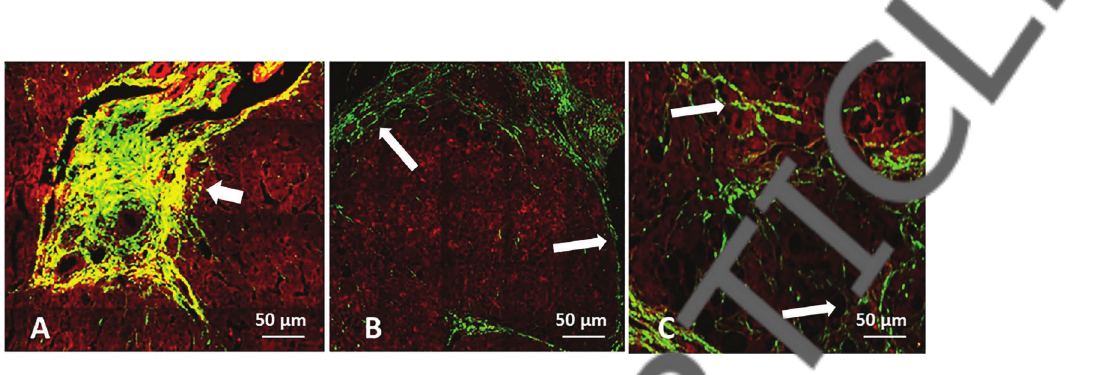
Figure 4. Second harmonic generation and two-photon excited fl uorescence images of different patterns of fi brosis by different etiologies. Collagen is stained green and liver cell structure is stained red. A , Primary biliary fi brosis, in which fi brosis began in portal tracts (arrow). B , Chronic hepatitis B, in which expanded portal tracts are linked by fi brous tissue and slender bridge septa are connected to a portal tract and central vein (arrows). C , Non-alcoholic steatohepatitis, showing pericellular fi brosis, fi brous lattice surrounding individual and small groups of hepatocytes and vacuoles cells